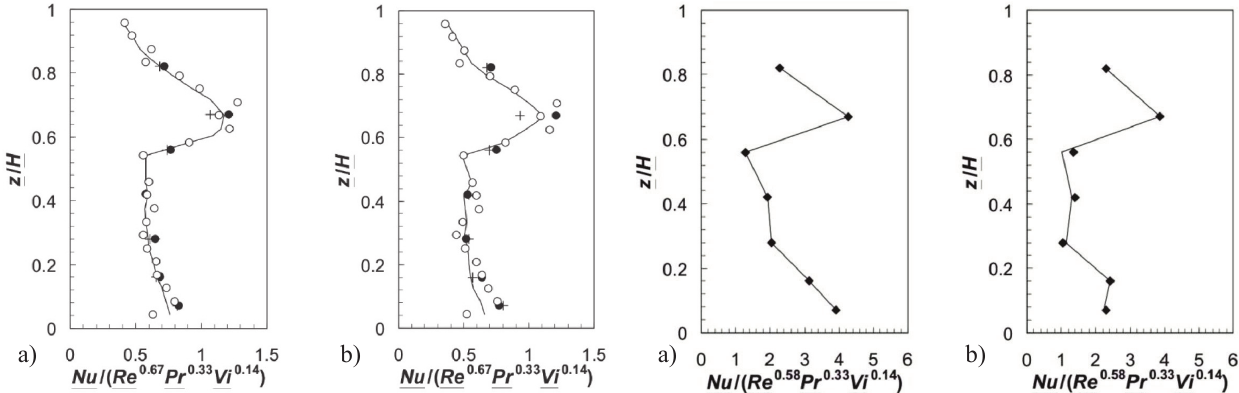
Fig. 12 – Comparison of the experimental (points) and cal­ culated (solid line) values of the function [Nu/(Re 0.58 Pr 0.33 Vi 0.14 )] = Cf f = f(z/H) for the system with A 315 (lower) – RT (upper) 1 2 impellers; air – glycerol system; transitional range of the